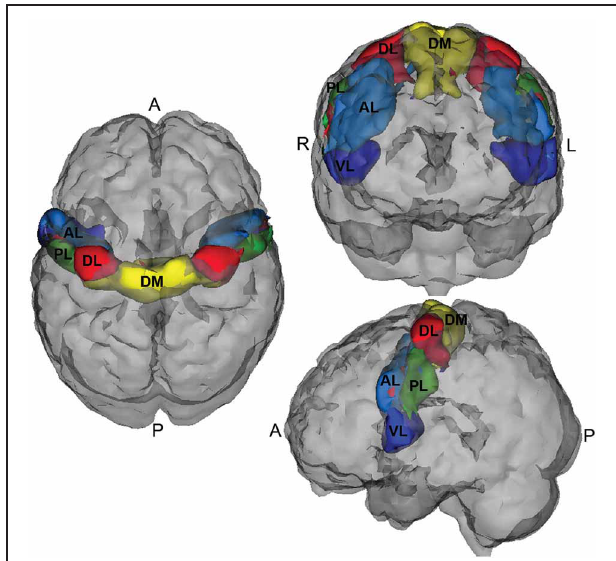
FIGURE 1 | Motor cortex parcellation.